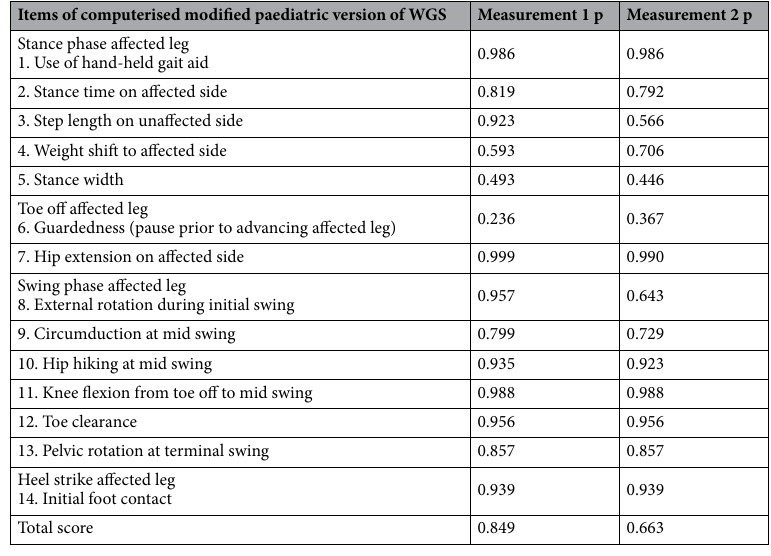
Table 4. Differences in assessment of specific participants by three independent examiners in measurement 1 and measurements 2. p—Probability index in Kruskal–Wallis ANOVA.